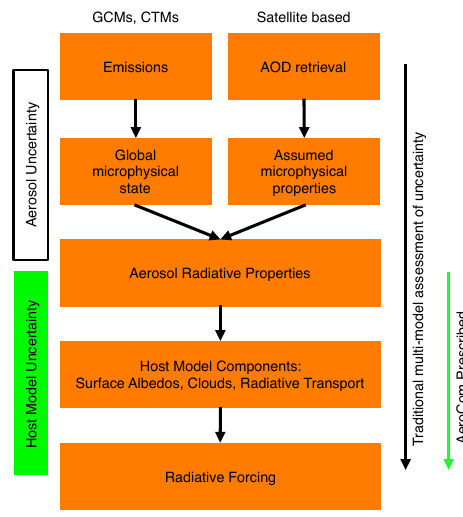
Fig. 1. Schematic of the steps involved in aerosol radiative forc- ing calculations from models and satellite observations, separating aerosol and host model processes.